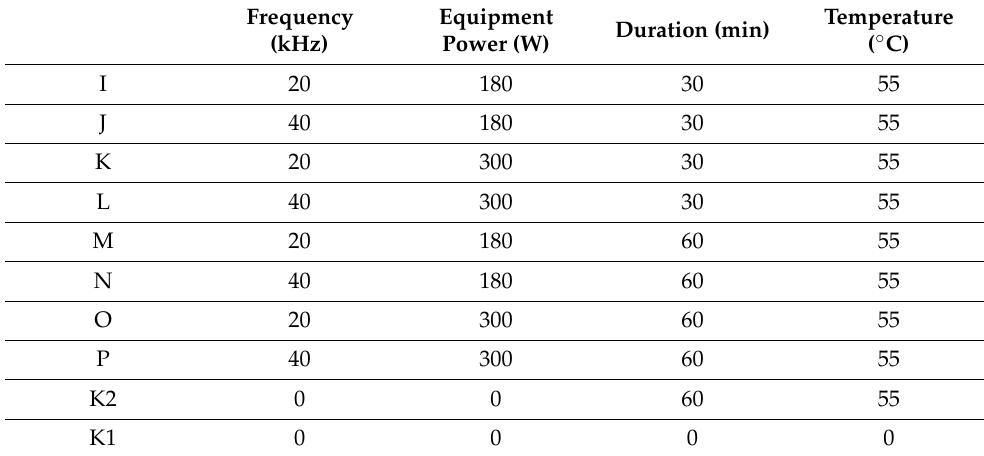
Table 1. Egg sample groups depending on the applied